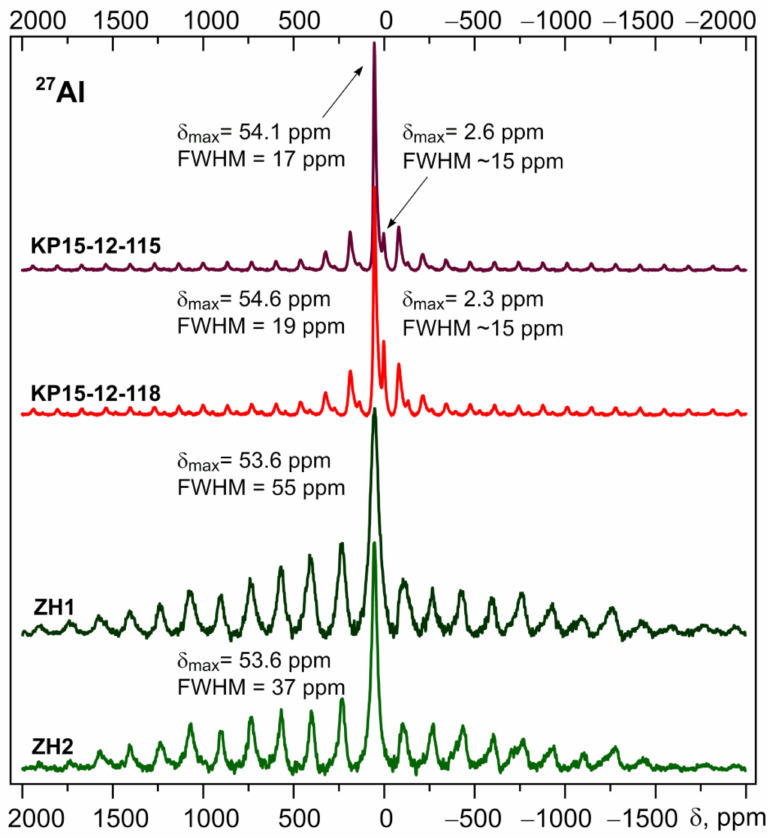
Figure 2. Overview 27 Al MAS NMR spectra of KP15-12-115, KP15-12-118, ZH1 and ZH2 samples in the range of chemical shifts from − 2000 ppm to 2000 ppm. The positions of the maxima of the central bands and their FWHM measured by the spectral contour are